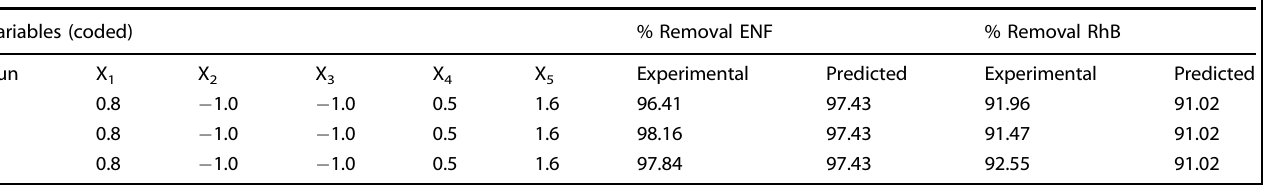
Table 3. Optimum conditions derived by